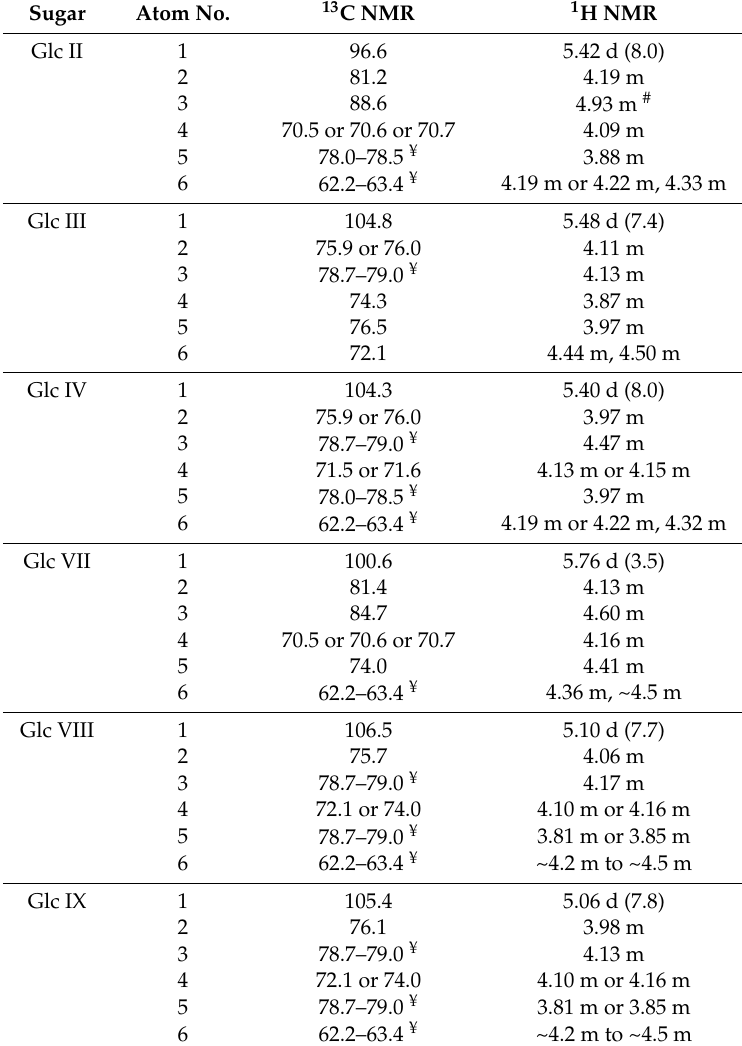
Table 3. 1 H and 13 C NMR (500 and 125 MHz, 300K) assignments of the C-13 glycosides of compound 1 in pyridine- d 5